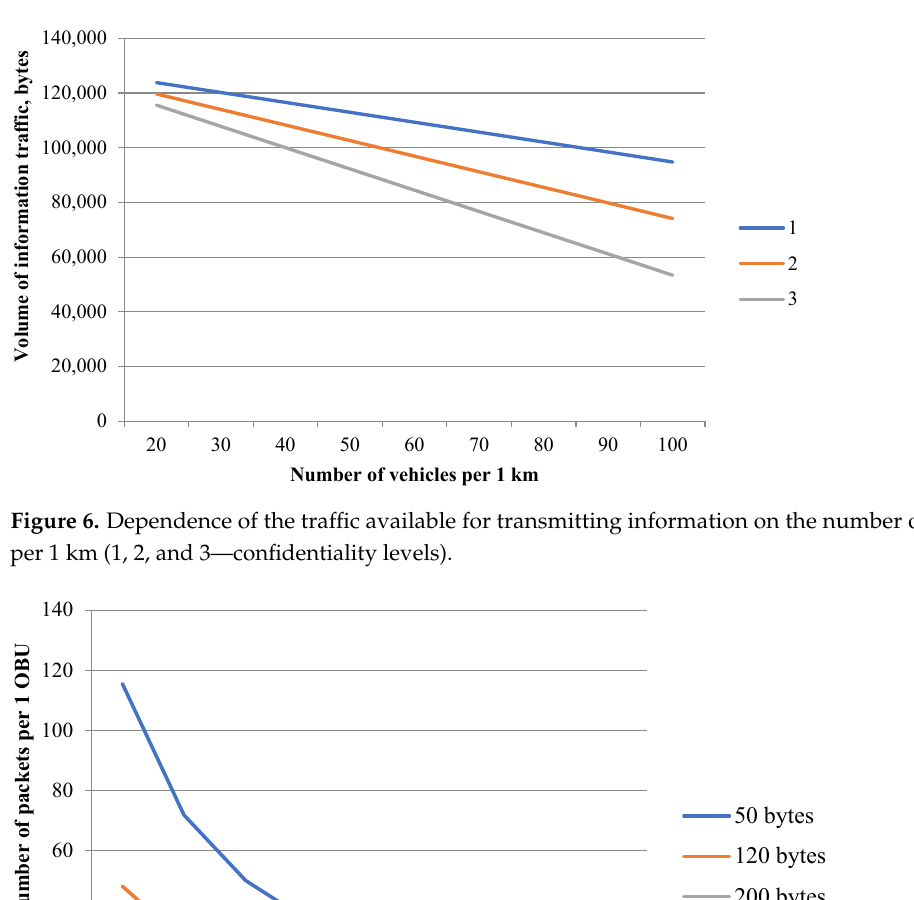
Figure 7. Average number of packets per OBU when using the 3rd confidentiality level.